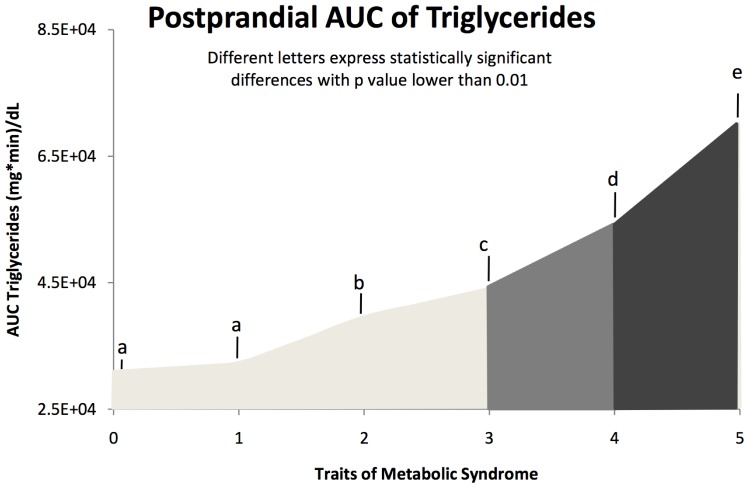
Postprandial AUC of triglycerides in relation to Mets traits.The magnitude of the AUC of postprandial TG increased in the sequence 0, 1<2 criteria <3 criteria <4 criteria <5 criteria. Variables were compared using ANOVA with sex and age as covariates. Different letters express statistically significant differences with a p value below 0.01.